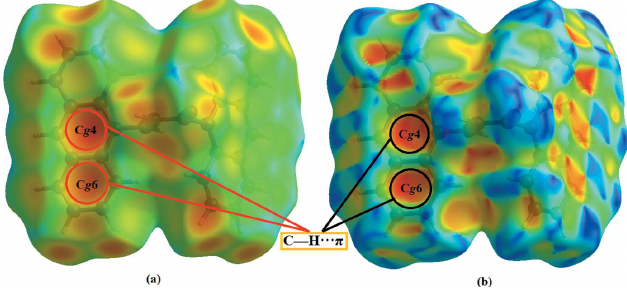
Figure 5 View of the Hirshfeld surfaces for (I) mapped over ( a ) d e and ( b ) shape- index with the pale-orange spot within the red circles showing the presence of the C—H (cid:3)(cid:3)(cid:3) (cid:2)